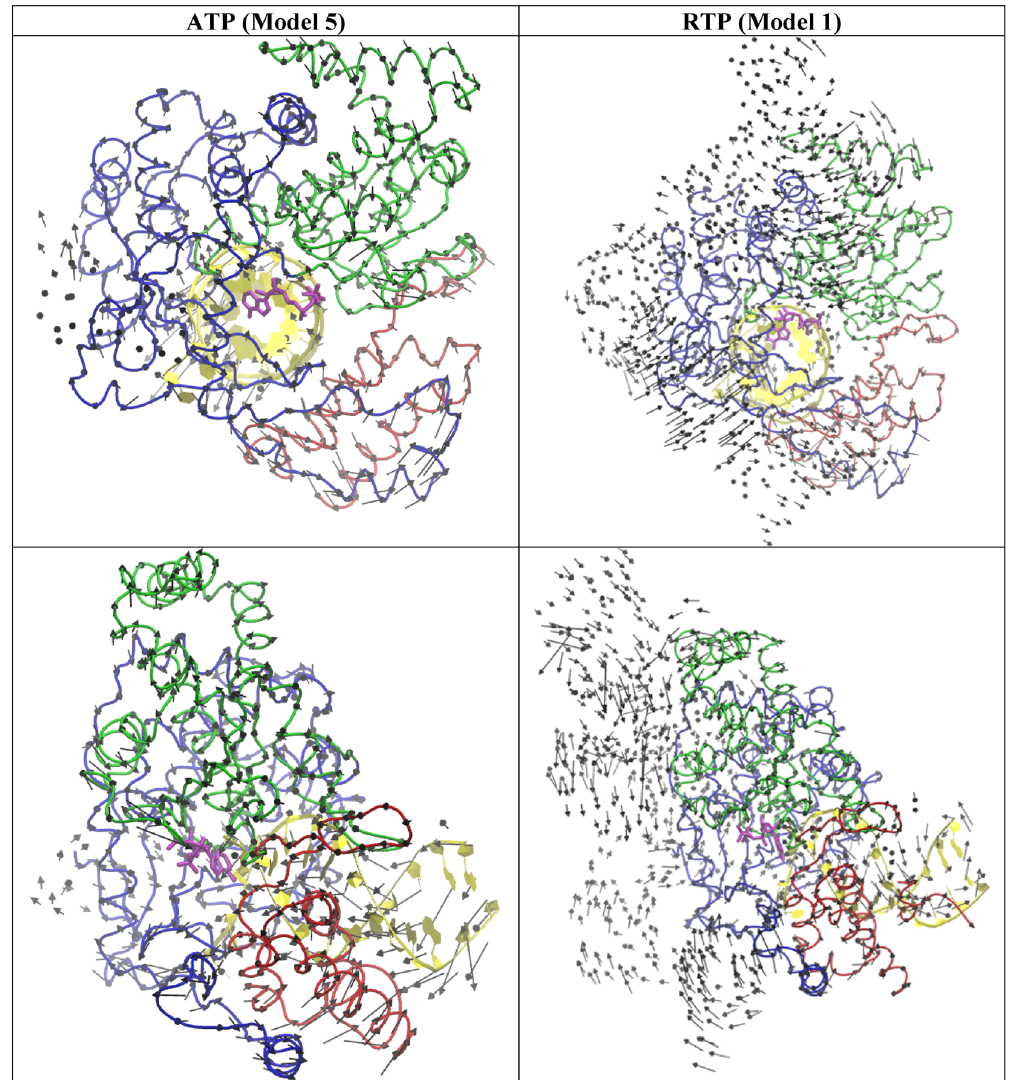
Figure 4. The top view (top) and the side view (bottom) of a selected normal mode from the ATP (model 5) and RTP system (model 1). RNA (yellow) and Thumb domain (Red), Palm domain (Green), and Finger domain (Blue) of RdRp is shown